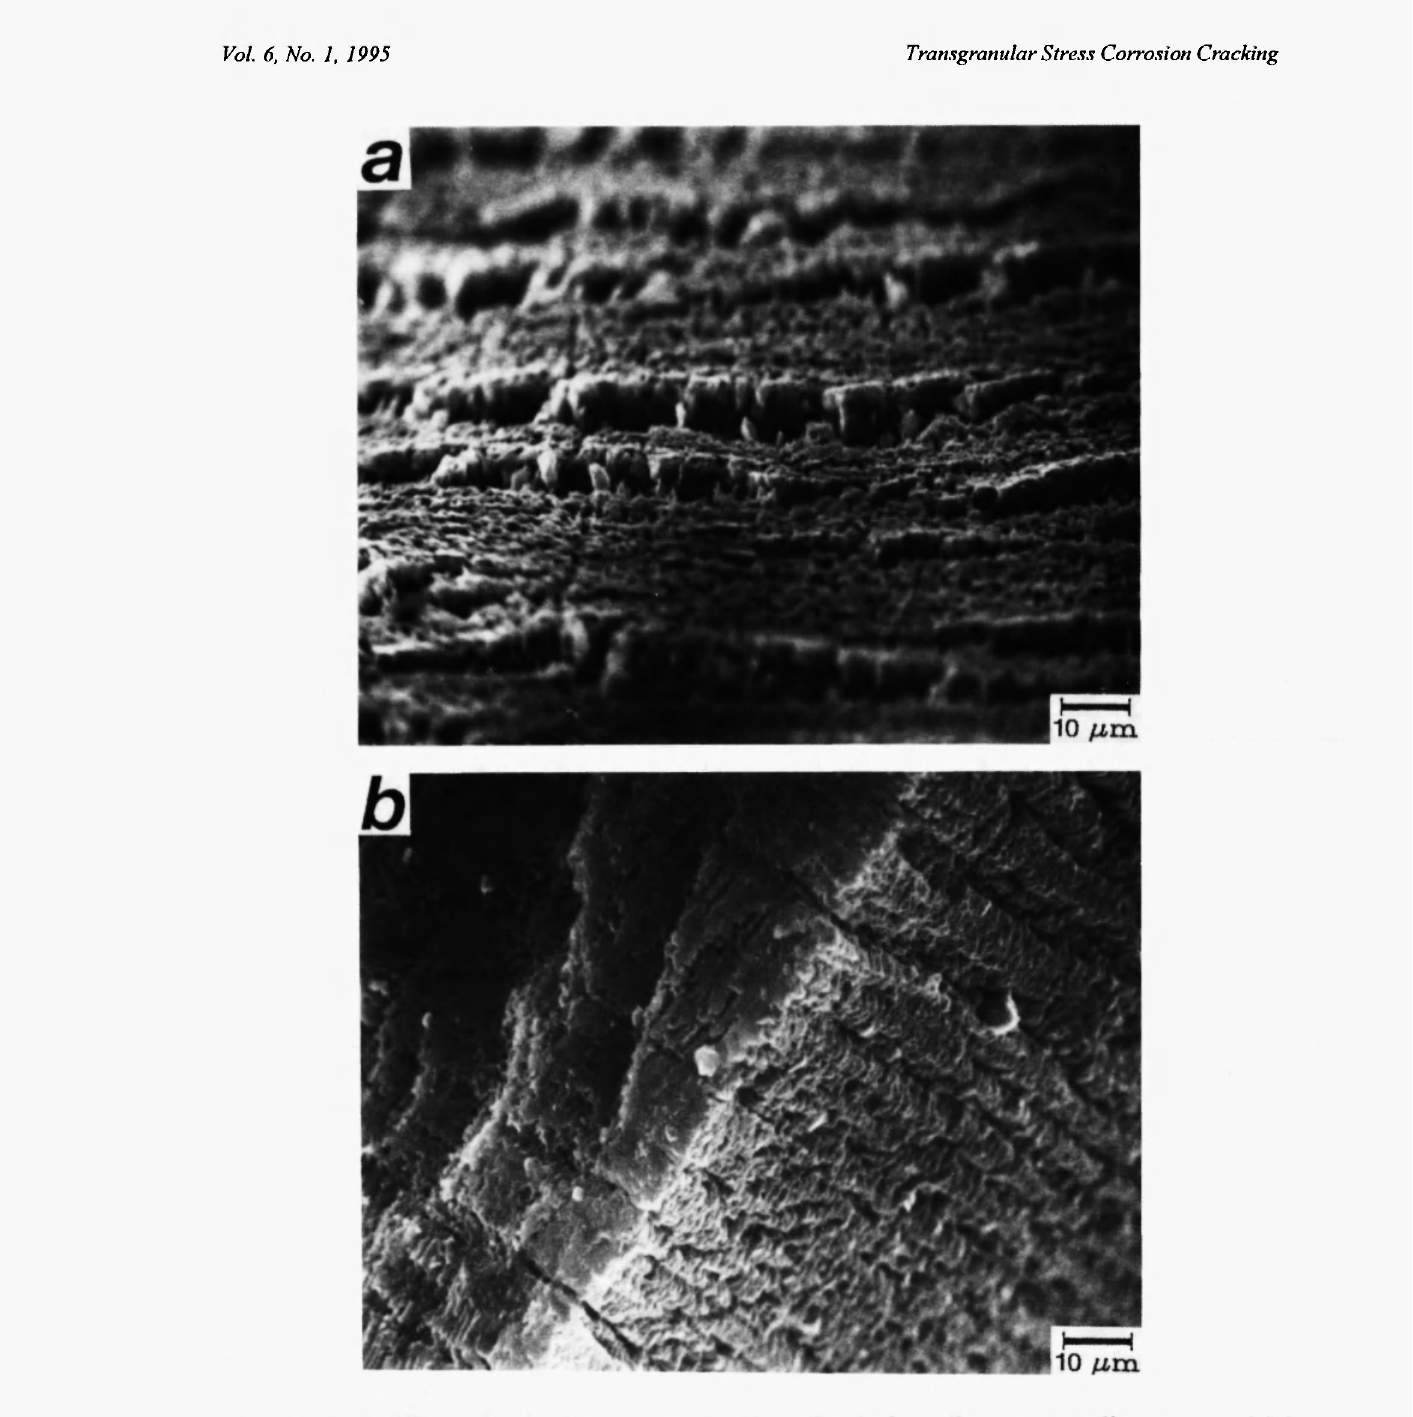
Fig. 5 Scanning electron micrographs showing dissolution of emergent slip steps at SCC specimen surfaces of (a) pure copper and (b) α-brass. The area shown in (b) is at the edge between the fracture surface (upper left) and the external